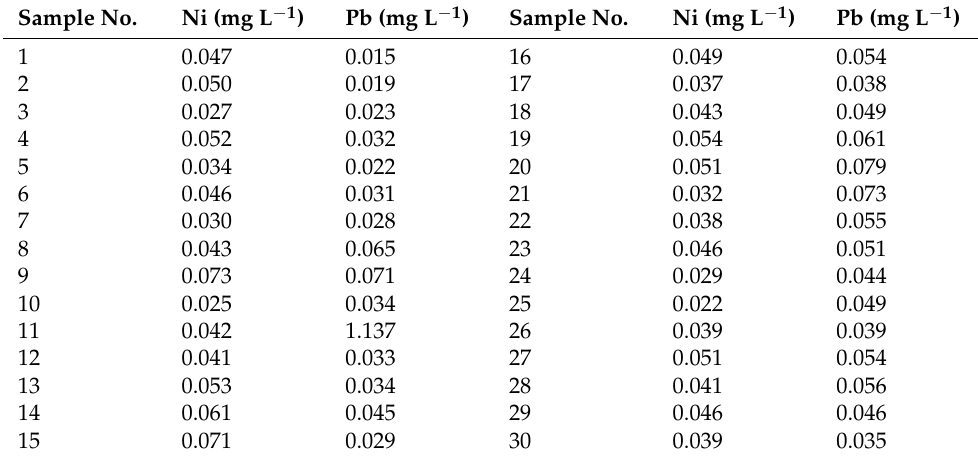
Table 2. Pb and Ni concentrations (mg L − 1 ) in Faisalabad metropolitan city effluent. Sample